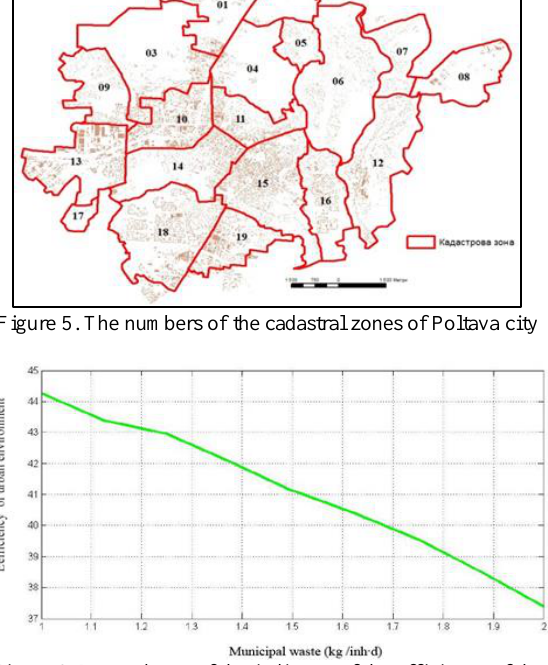
Figure 6. Dependence of the indicator of the efficiency of the urban environment in the cadastral zone of 10 m. Poltava city from the amount solid household waste